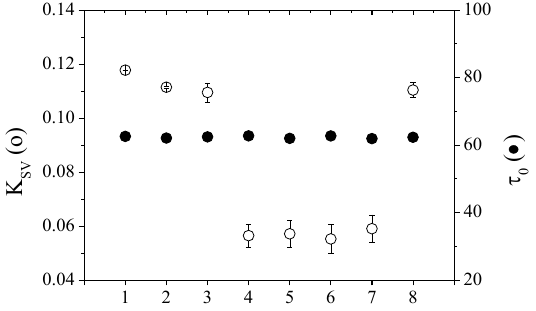
Figure 8. Life time τ 0 in the absence of oxygen and K SV ( T ) calculated in various conditions at 20 ◦ C; x-axis labels refer to (1) just prepared membrane in air; (2) in air after heat treatment at 90 ◦ C for 24 h; (3) in water; (4) in white wine; (5) in red wine; (6) in 12% ethanol solution; (7) in water after (6); (8) in water after heat treatment at 90 ◦ C for 24